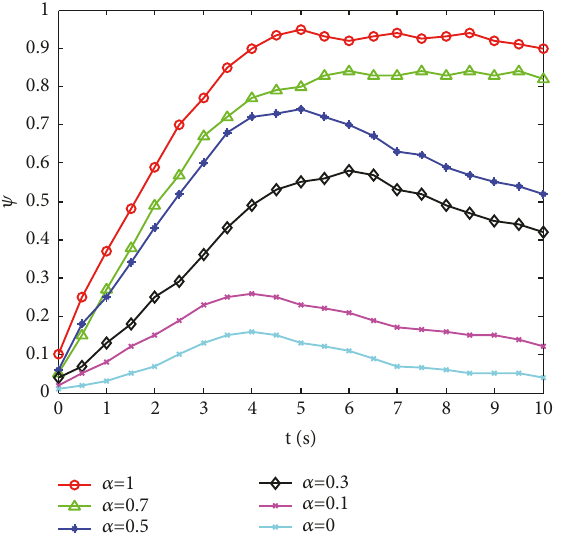
Figure 9: The polarization index of flocking system with different 𝛼 .